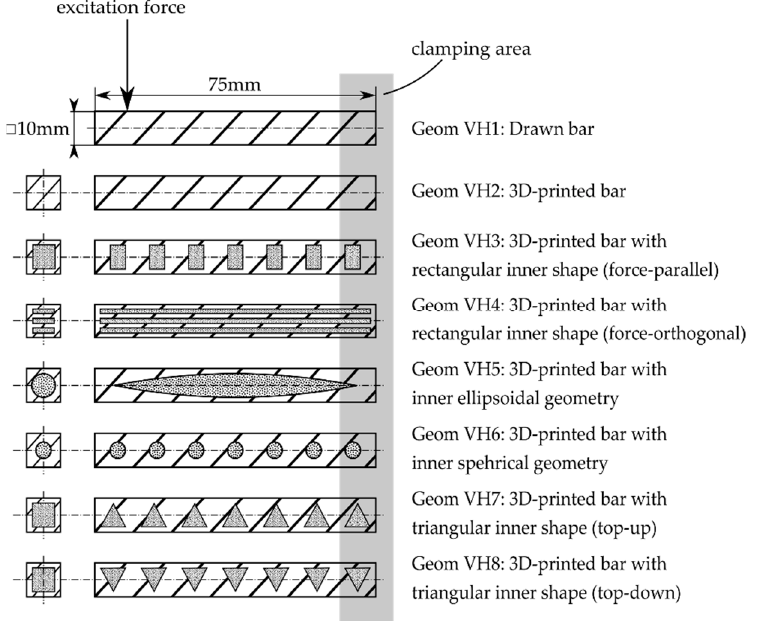
Figure 5. Selection of investigated samples.